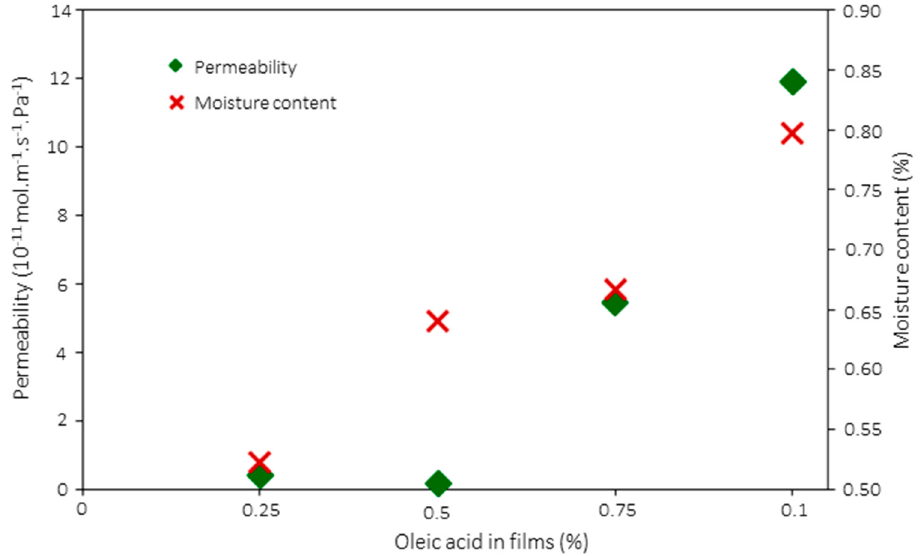
Figure 3. Effect of oleic acid and moisture content in films on their permeability to O 2 . Standard deviation of the presented data was < 10%.